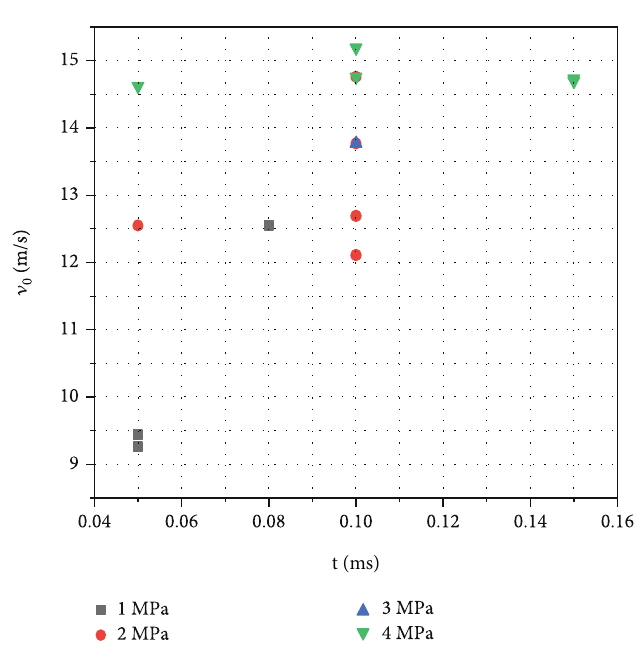
Figure 10: The steel projectile velocity under di ff erent control